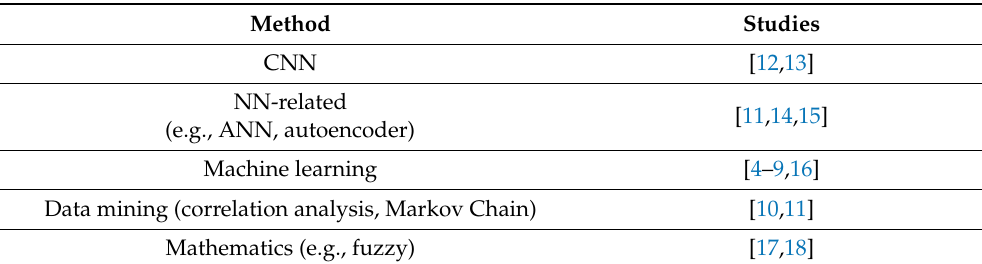
Table 1. The main anomaly detection-related approaches in predictive maintenance.